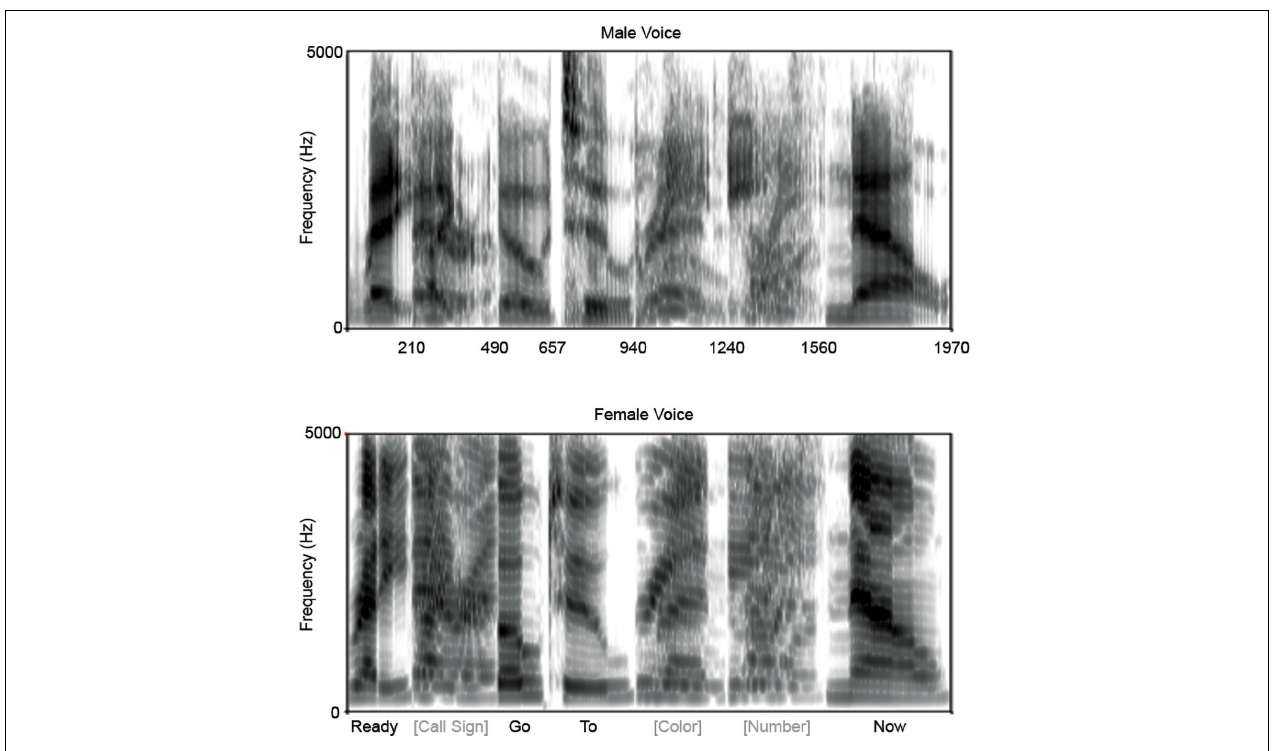
FIGURE 1 | Spectrograms of stimuli. For each voice, male (top) and female (bottom) , only one token of ‘ready,’ ‘go,’ ‘to,’ and ‘now’ were used, while two call signs, three colors, and multiple numbers were used. The segments of the spectrograms corresponding to the latter three are averages across the multiple utterances. The total utterance duration was 1,970 ms. Time labels on the x -axis of the male voice correspond to the word boundaries (e.g., 210 ms is when ‘ready’ ends and the call signs